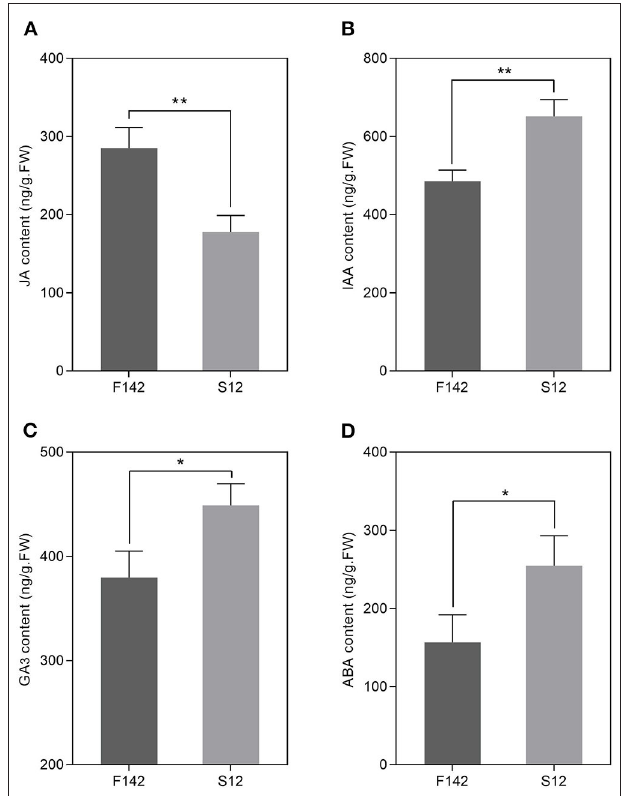
FIGURE 6 | Changes in JA, IAA, GA 3 , and ABA concentrations in F142 and S12. (A) JA concentration. (B) IAA concentration. (C) GA 3 concentration. (D) ABA concentration. Three independent biological replicates were used. Three biological replicates were assessed. Paired t -tests, * p < 0.05, ** p < 0.01.